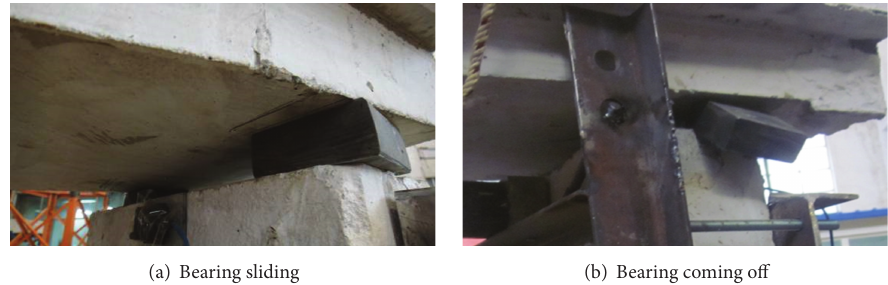
Figure 7: Damage to